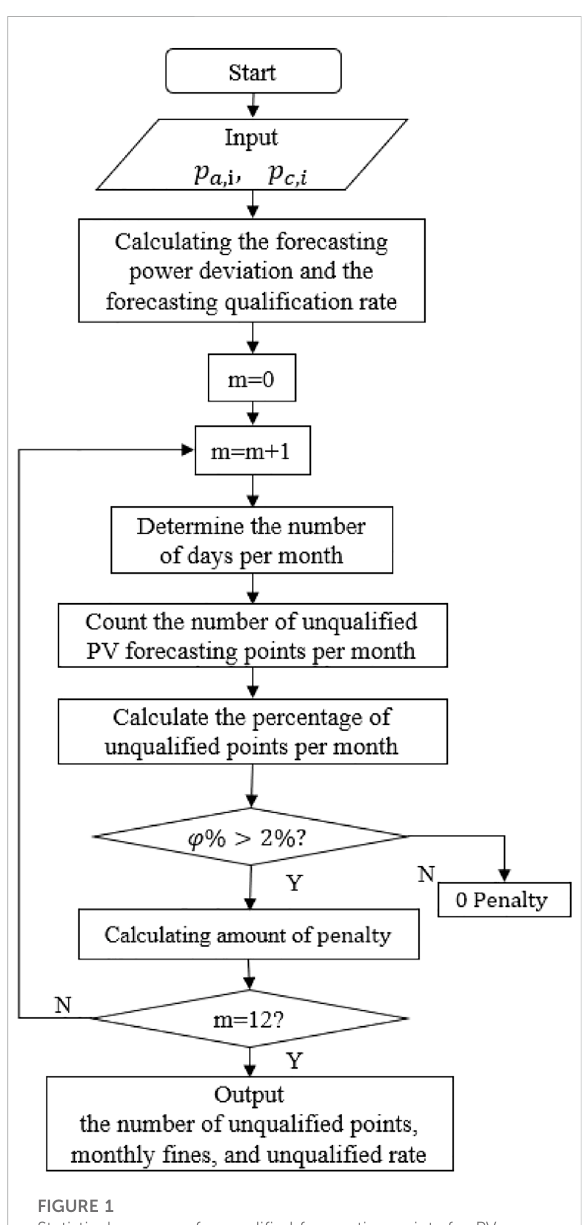
FIGURE 1 Statistical process of unquali fi ed forecasting points for PV power station. The steps are as